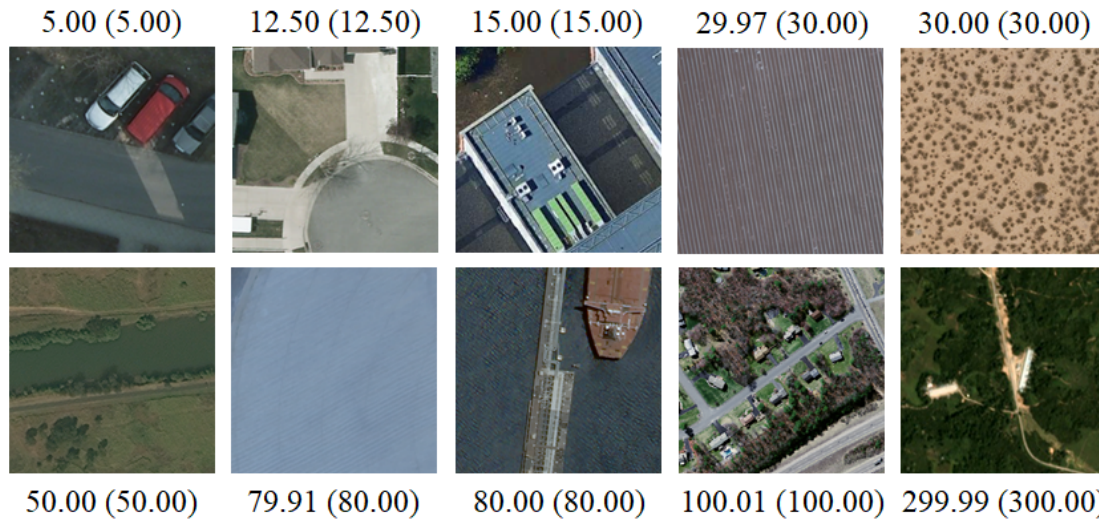
Figure 8. GSD prediction results of dataset 2 (mixed dataset) with the image size of 256. The number represents the GSD prediction, whereas the number in the parentheses indicates the ground truth GSD